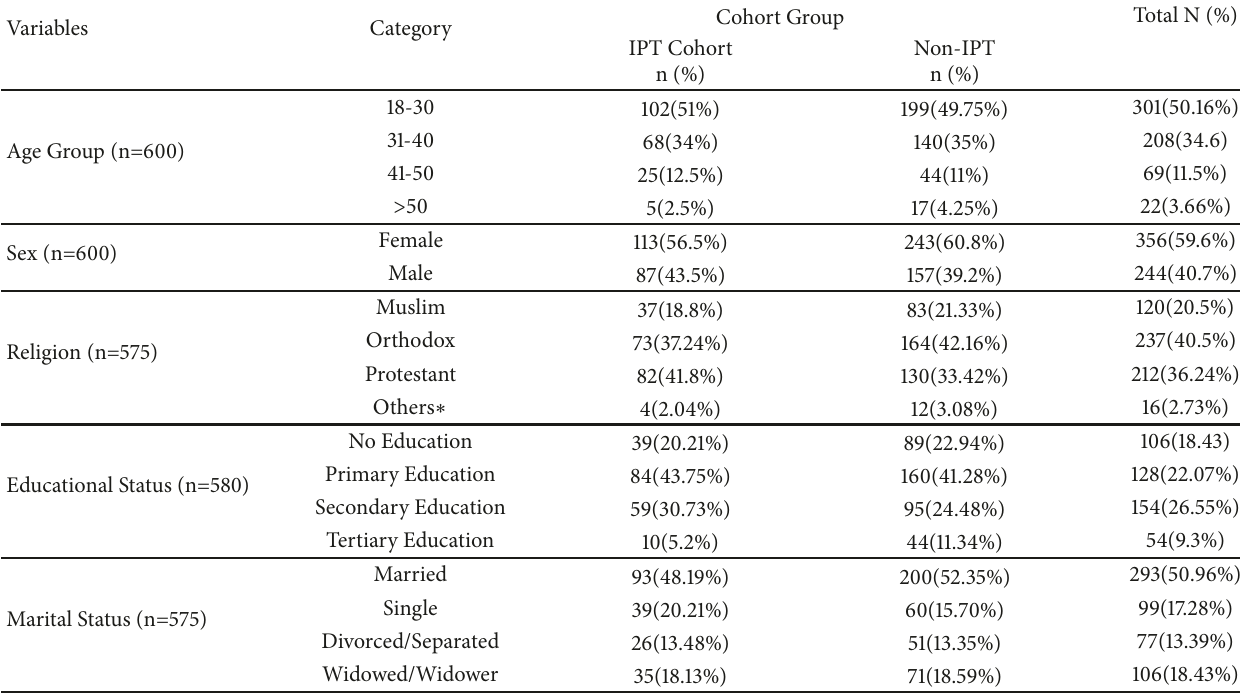
Table 1: Baseline sociodemographic characteristics of PLWH at Nekemte referral hospital and Nekemte Health center followed from